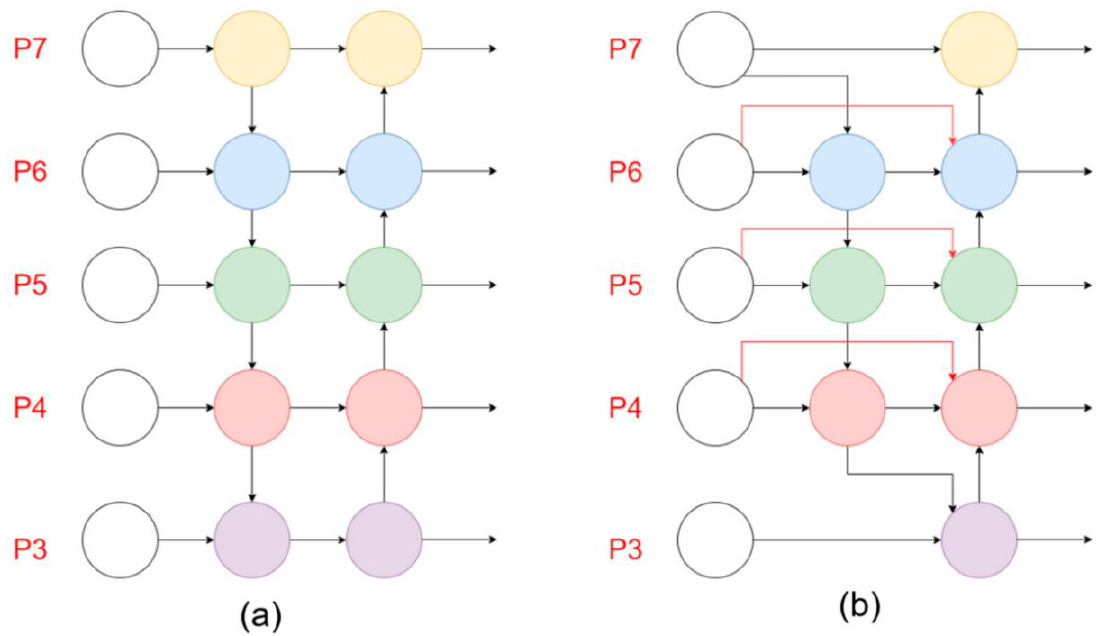
Figure 8. ( a ) Architecture of PAFPN; ( b ) Architecture of BIFPN.P3-P7 are input characteristics .